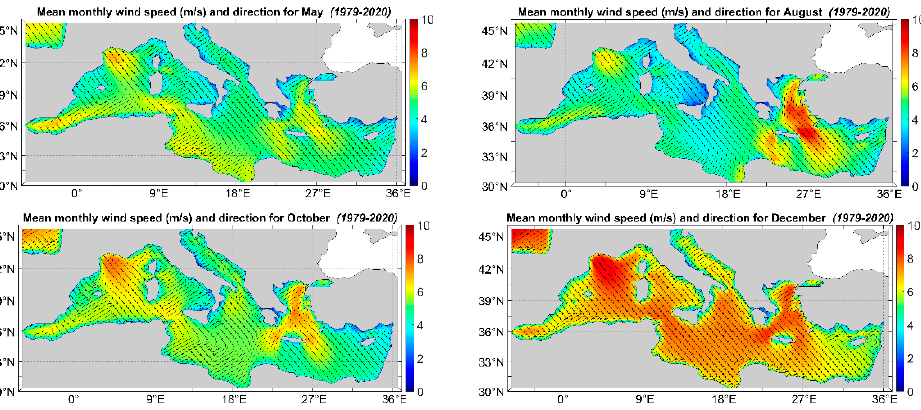
Figure 13. Mean monthly wind speed and direction for May, August, September and December.